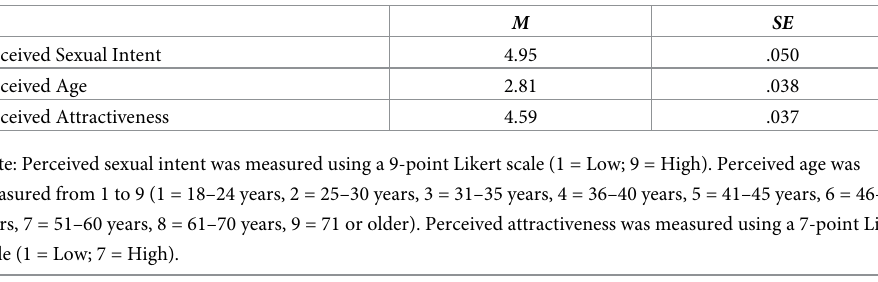
Table 1. Mean ratings of target women for the three predictor variables.